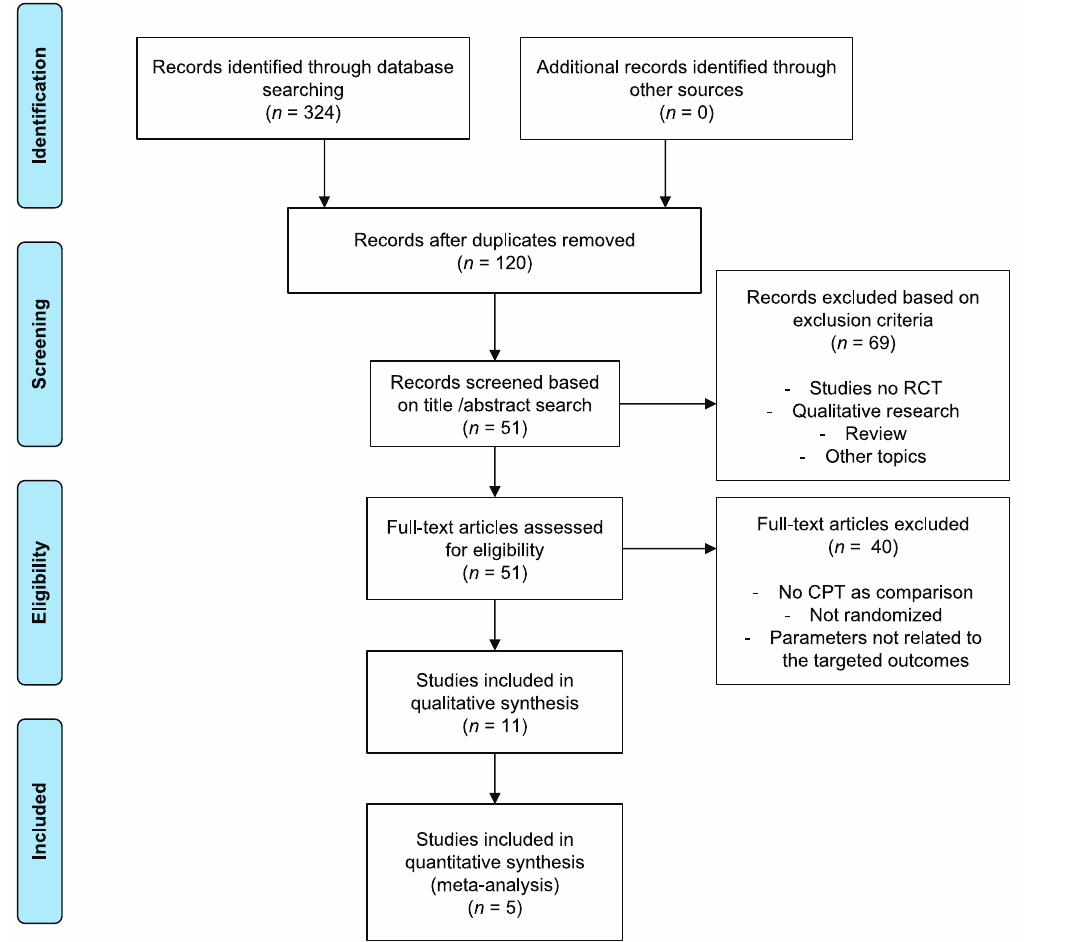
Figure 1. Flow diagram of the included studies.